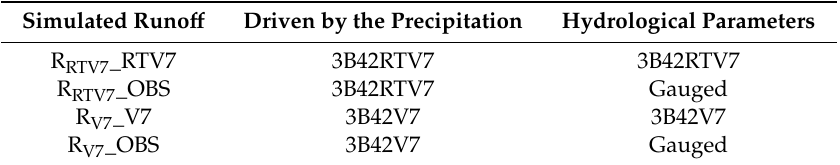
Figure 8. Scatter plots of the gauged and simulated runoff by using VIC hydrological models in the upper Yangtze River basin: ( a ) driven by 3B42TRV7 using the parameters obtained from 3B42RTV7; ( b ) driven by 3B42RTV7 using the parameters obtained from the gauged precipitation; ( c ) driven by 3B42V7 using the parameters obtained from 3B42V7; and ( d ) driven by 3B42V7 using the parameters obtained from gauged precipitation. Table 3. The definition of the simulated runoff driven by TMPA 3B42TRV7/V7 using different hydrological parameters in the upper Yangtze reaches.